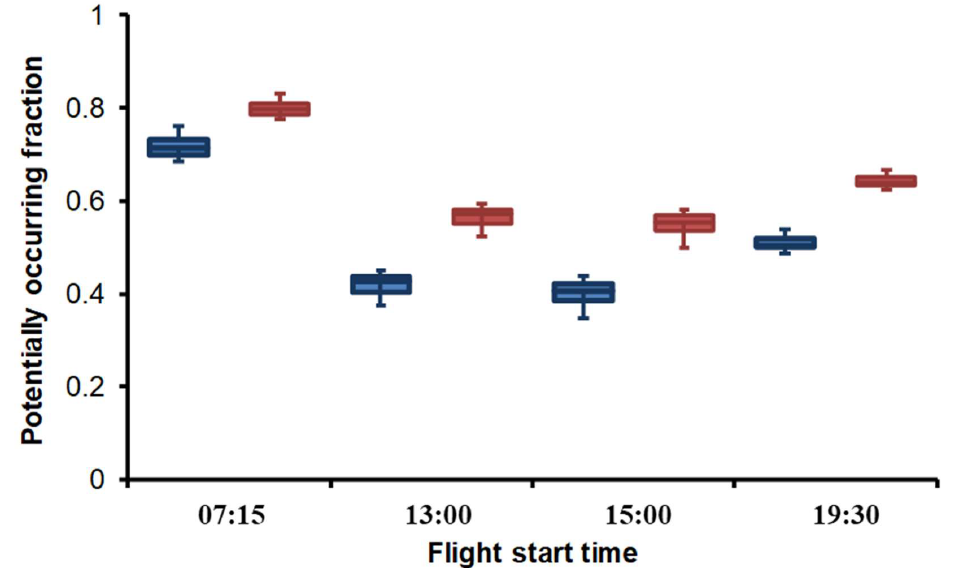
Figure 8. The potentially occurring fraction (POF) of alien species in the northern side channel along the river Waal near Gameren derived from remotely sensed water temperatures during a hot summer day.